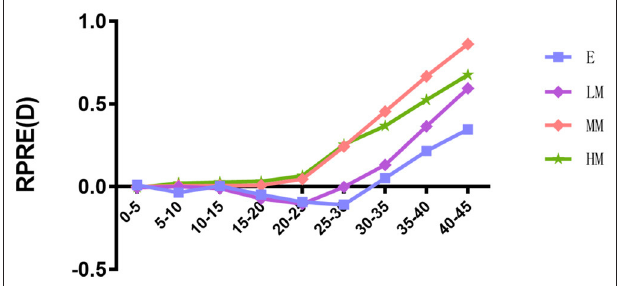
At eccentricities between 25 and 30 ◦ , RPRE values were normally distributed, and the RPREs of the four refractive groups (E, LM, MM, and HM) were 0.026 D ± 0.392, − 0.037 D ± 0.479, 0.244 D ± 0.388, and 0.255D ± 0.378, respectively. The RPRE of the LM group was less than that of the MM and HM groups, respectively, and the differences were statistically significant ( P < 0.05; Figure 4F ).